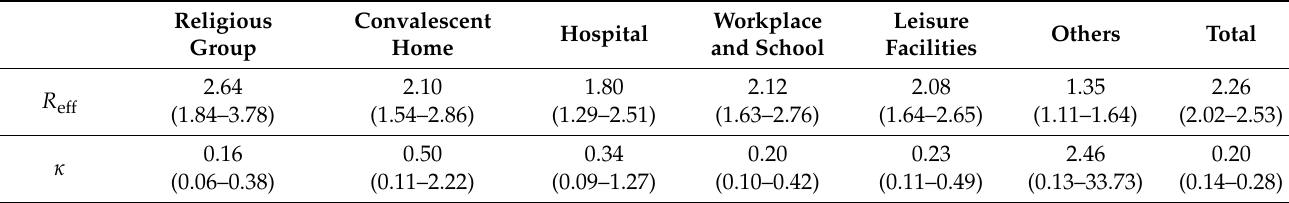
κ Table 2. Inference results for comparing the effective reproduction number and dispersion of clus- ters as initial case = 20 for COVID-19 in South Korea.